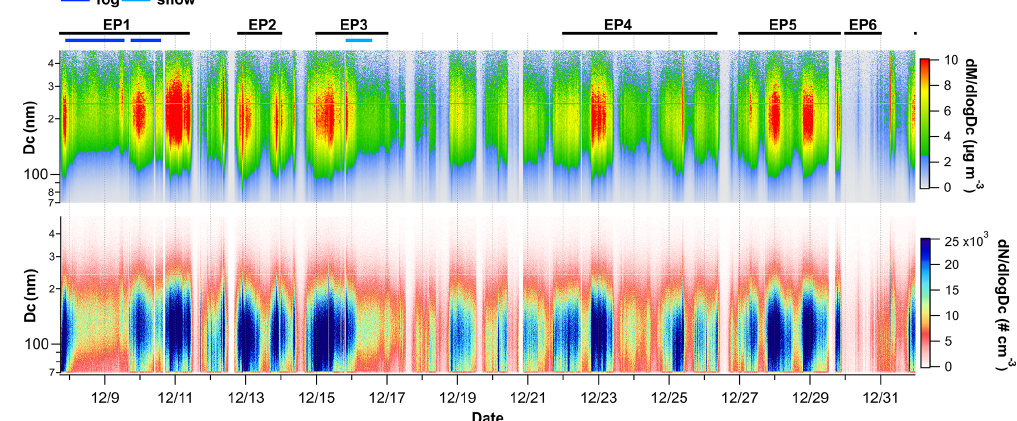
Figure 3. Time series of the mass size distribution and number size distribution of r BC, as measured by the